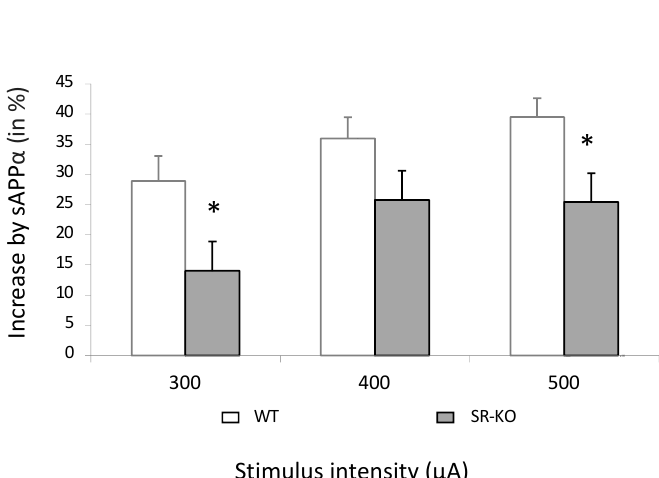
Figure 4. sAPP α -related improvement of NMDAR activation is lowered in SR-KO mice. ( A ) Bar graphs illustrating the effects of sAPP α (1 nM) on I SE of NMDAR-mediated fEPSPs in 14 slices from 5 WT mice (** and *** for p < 0.01 and p < 0.0001, respectively, compared to control aCSF, paired t -test). In the insert are superimposed representative traces obtained at 400 µ A stimulation intensity before (solid line) and after (dotted line) sAPP α supplementation. ( B ) Bar graphs illustrating the effects of sAPP α (1 nM) on I SE of NMDAR-mediated fEPSPs in 20 slices from 8 SR-KO mice (* and ** for p < 0.05 and p < 0.01, respectively, compared to control aCSF, paired t -test). In the insert are super- imposed representative traces obtained at 400 µ A stimulation intensity before (solid line) and after (dotted line) sAPP α supplementation. ( C ) Comparison of the percent increase in NMDAR-related I SE by sAPP α calculated in slices from WT and SR-KO mice plotted against current intensity (* for p < 0.05 compared to adult mice one-way